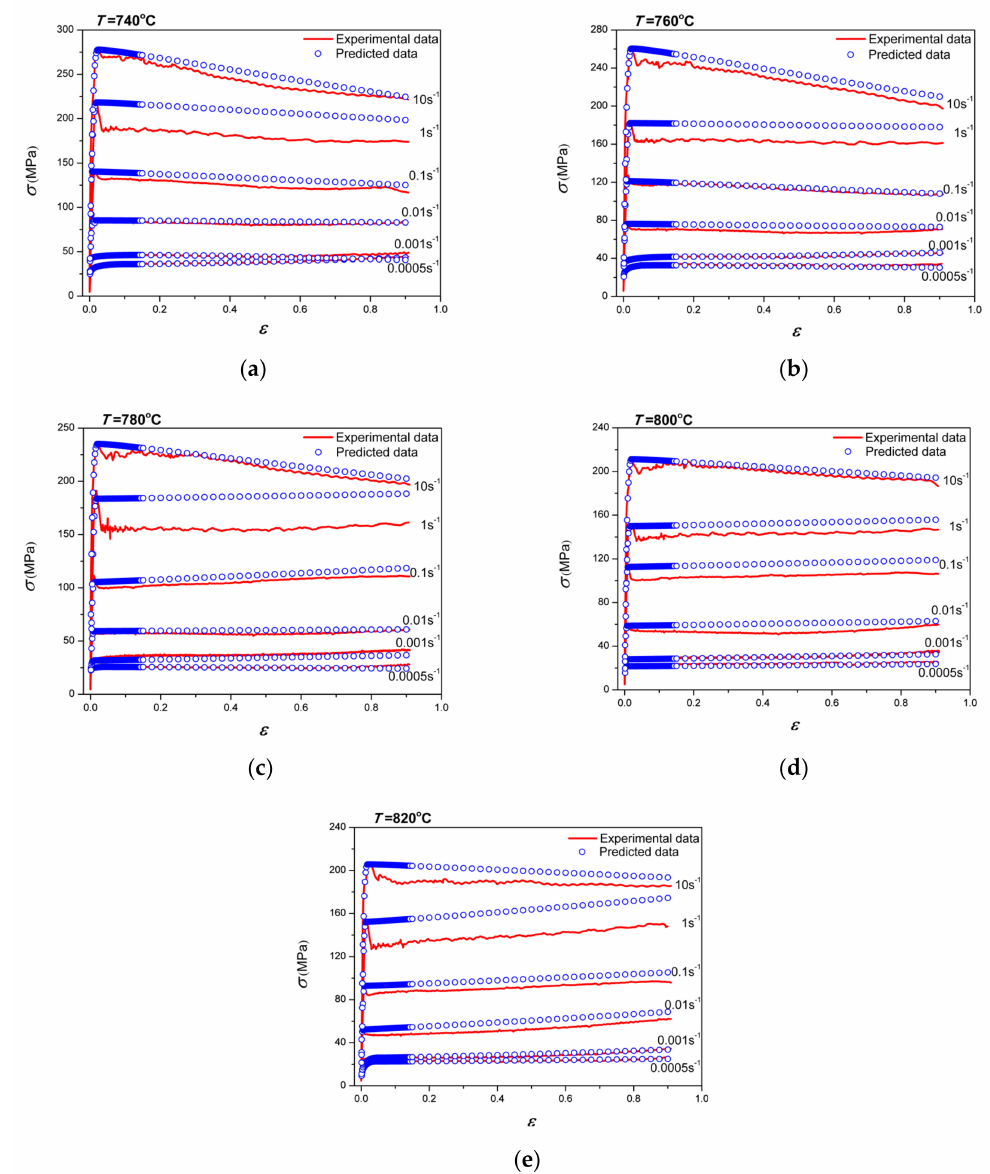
Figure 8. Comparisons between the experimental and predicted flow stress at deformation temperatures of: ( a ) 740 ◦ C; ( b ) 760 ◦ C; ( c ) 780 ◦ C; ( d ) 800 ◦ C; and ( e ) 820 ◦